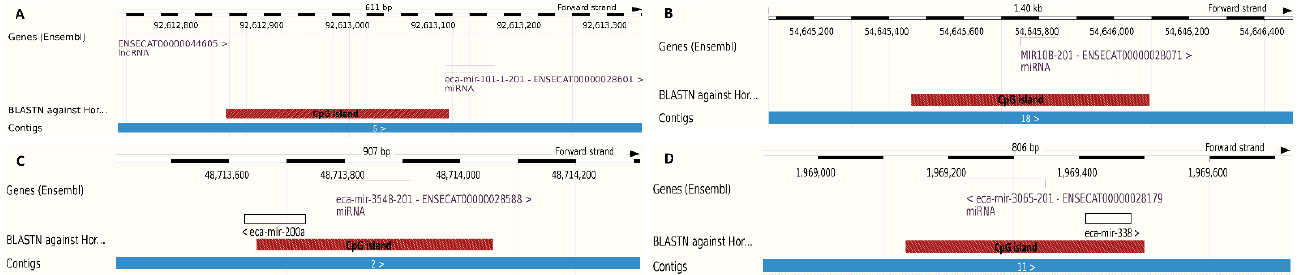
Figure 1. Graphical visualization of CpGs islands identified within the investigated microRNA genes. ( A )—eca-mir-101-1; ( B )—eca-mir-10b; ( C )—eca-mir-200a; ( D )—eca-mir-338. Blue bars indicate chromosomes; brown bars stand for identified CpG islands; transparent bars indicate microRNA precursors. The graphics were prepared using Ensembl genome browser [33] and EcuCab3.0 genome assembly. The localization of eca-mir-200a and eca-mir-338 was manually added since it is not marked in